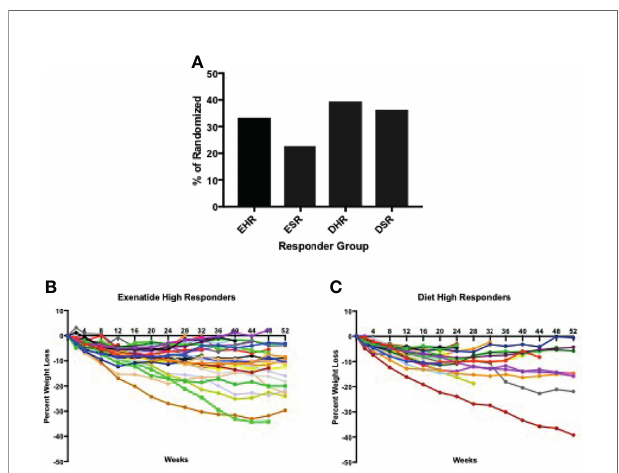
FIGURE 1 | (A) Percentage of high and super responders among those randomized to exenatide and diet groups. (B, C) Individual weight trajectories in exenatide high responder group (B) and diet high responder group (C) . EHR exenatide high responder. ESR exenatide super responder. DHR diet high responder. DSR diet super responder.